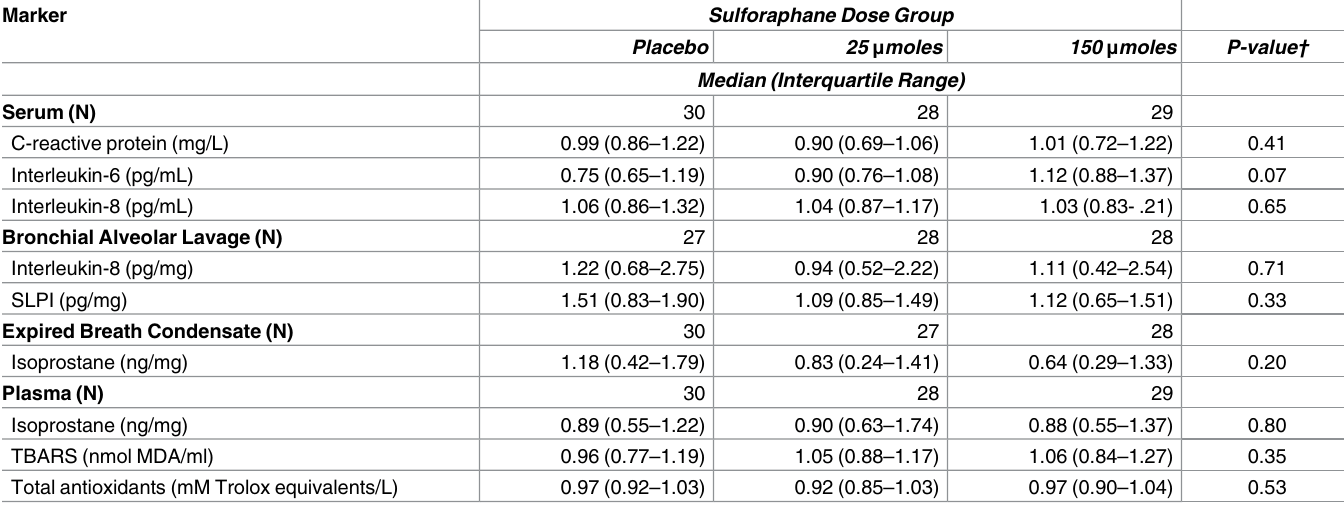
Table 4. Fold-change * in inflammatory markerconcentrations by treatment